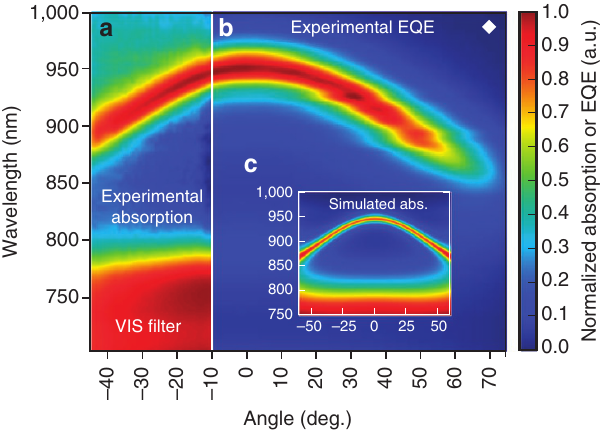
Figure 3 | Cavity-induced dependence of the resonance wavelength on the angle of light incidence. Angularly and spectrally resolved behaviour of a ZnPc:C 60 sample resonating at 950nm when the angle of incidence is 0 (cid:2) (device marked as ~ in Fig. 2a). ( a ) Experimental device absorption. ( b ) Experimental EQE. ( c ) Simulated device absorption. All graphs are normalized. For wavelengths below 800nm, the neat absorber sequence extinguishes light outside the microcavity (see a , c ) and, therefore, efficiently reduces the photo-response in the visible spectrum (compare b